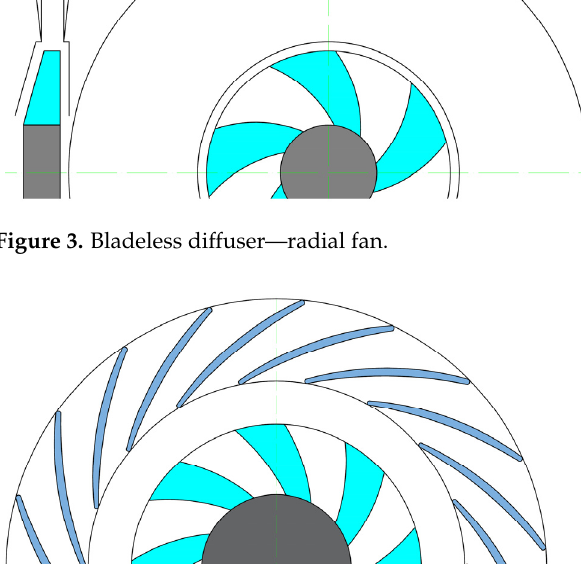
Figure 4. Blade diffuser—radial fan—with inlet bladeless part.